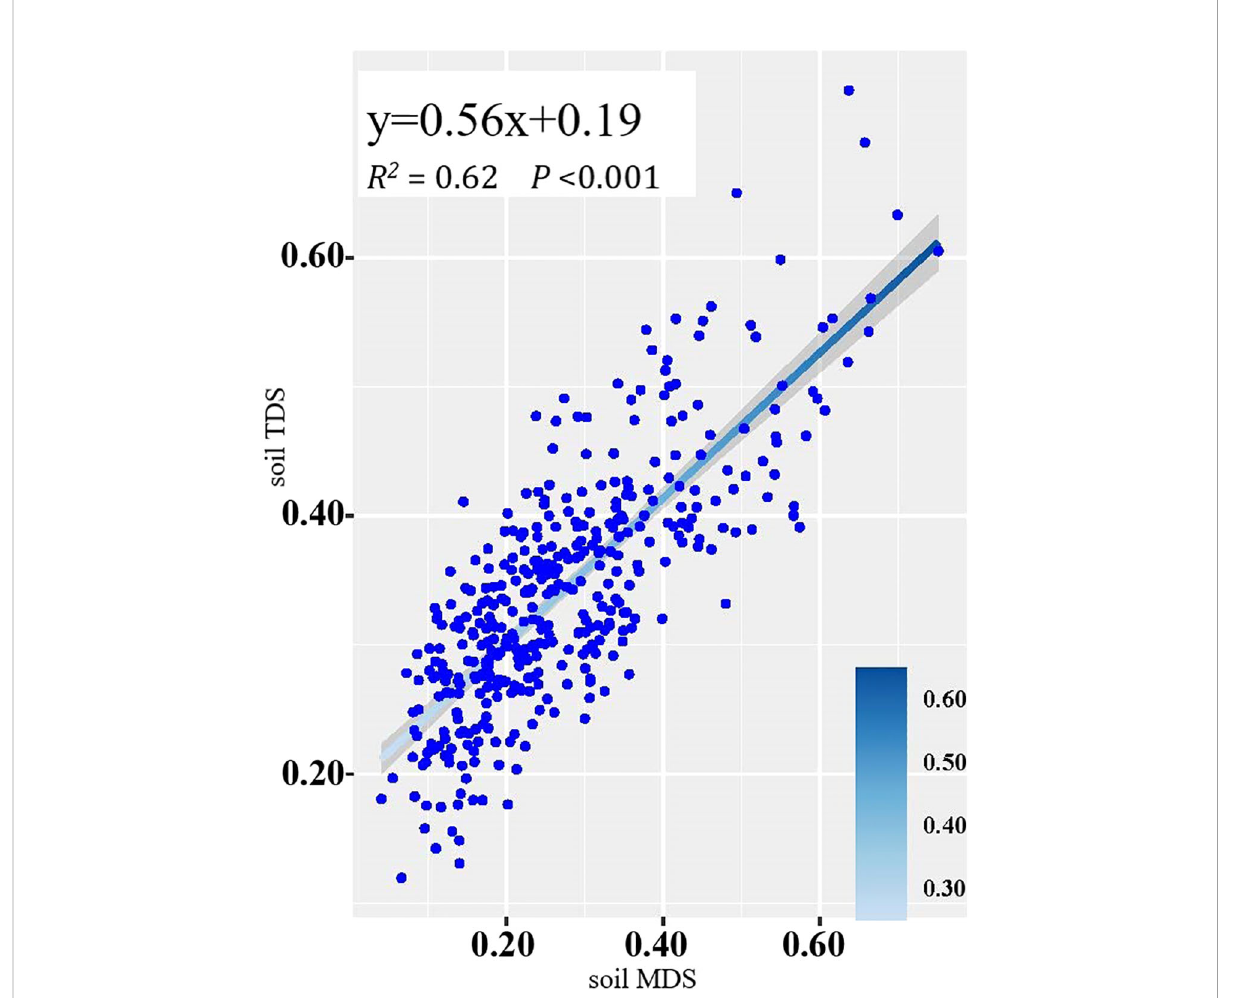
FIGURE 3 Linear fi tting of SPI s based on the soil MDS and soil